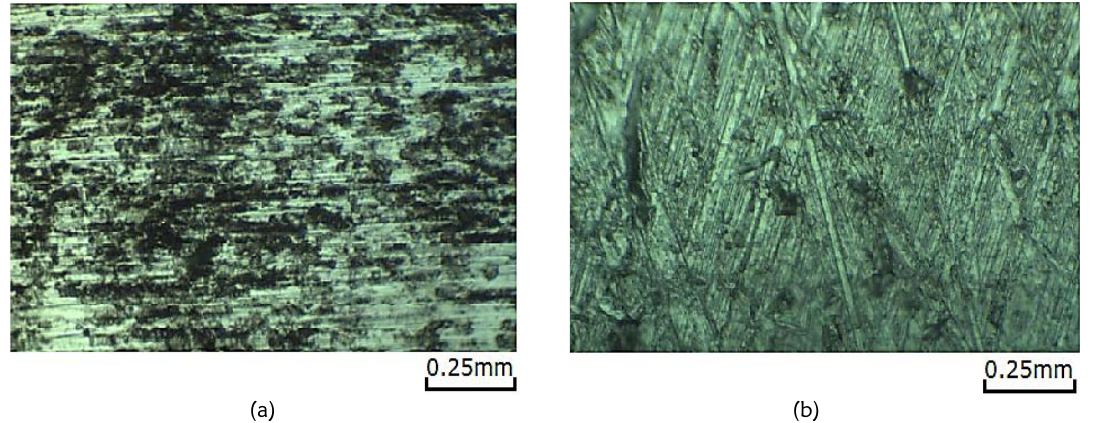
Figure 9: Microstructure of aluminium alloy- various percentages of rice husk ash (RHA) hybrid composites (a) 6% and (b) 2%.